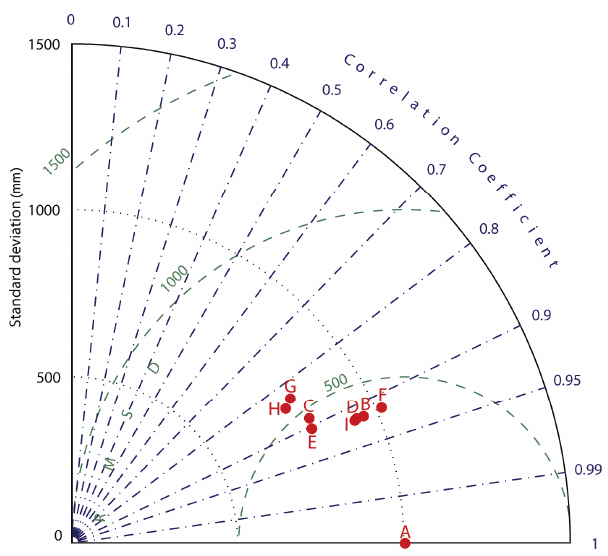
Fig. 8. Taylor plot with observed runoff (A) and modeled values using FCLIM (B), CRUCL 2.0 (C), original MAPSS parameterization (D), WorldClim (E), TMCF (F), TRMM (G), WindPPT (H), and NS (I) datasets.